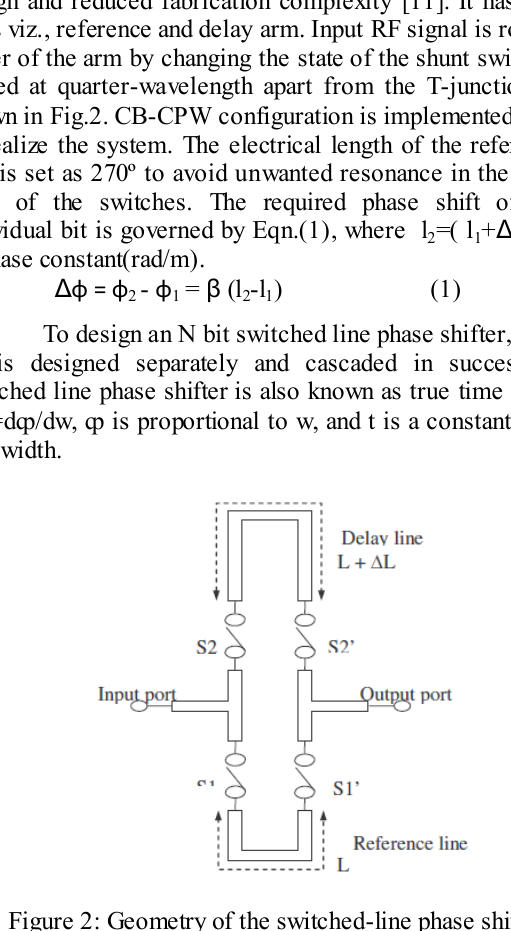
Figure 2: Geometry of the switched-line phase shifter